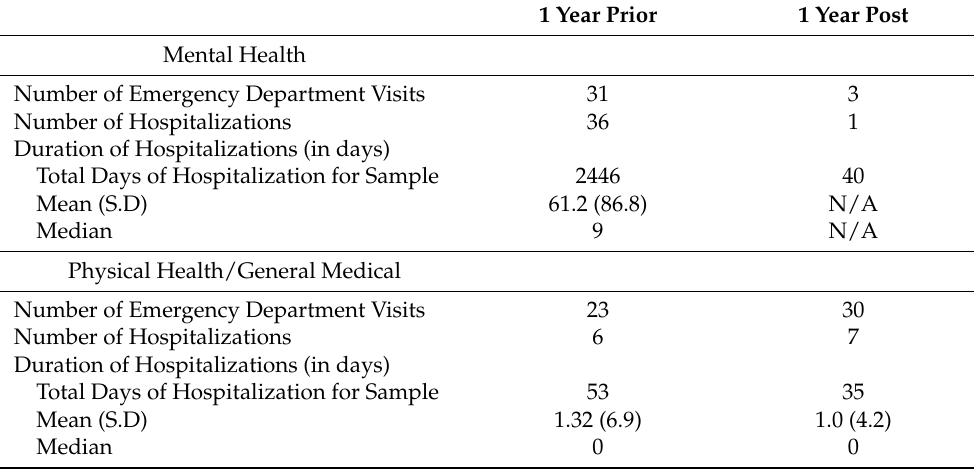
Table 2. Hospital Utilization and Emergency Department Visits Pre and Post SET for Health ( n =